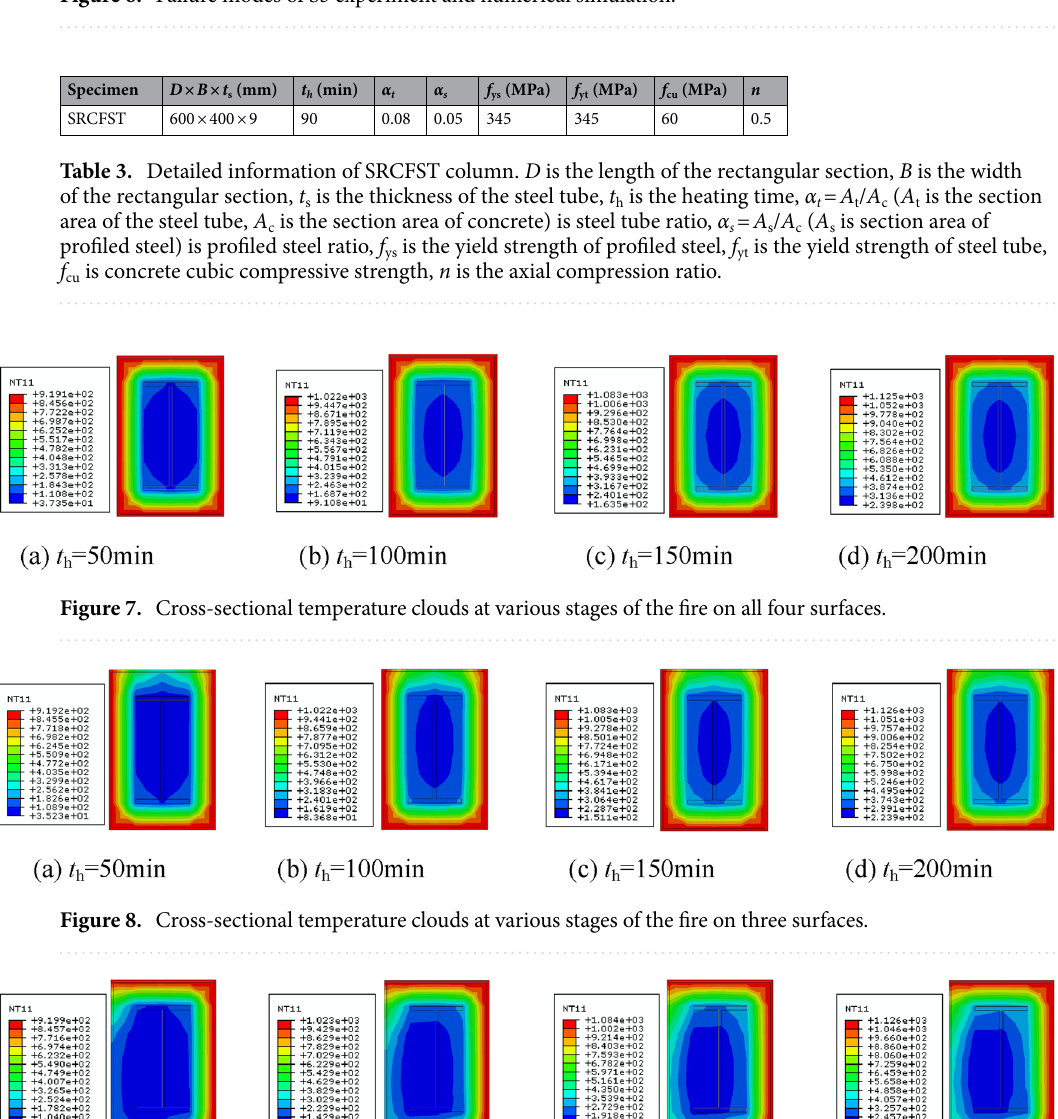
Figure 6. Failure modes of S3 experiment and numerical simulation.